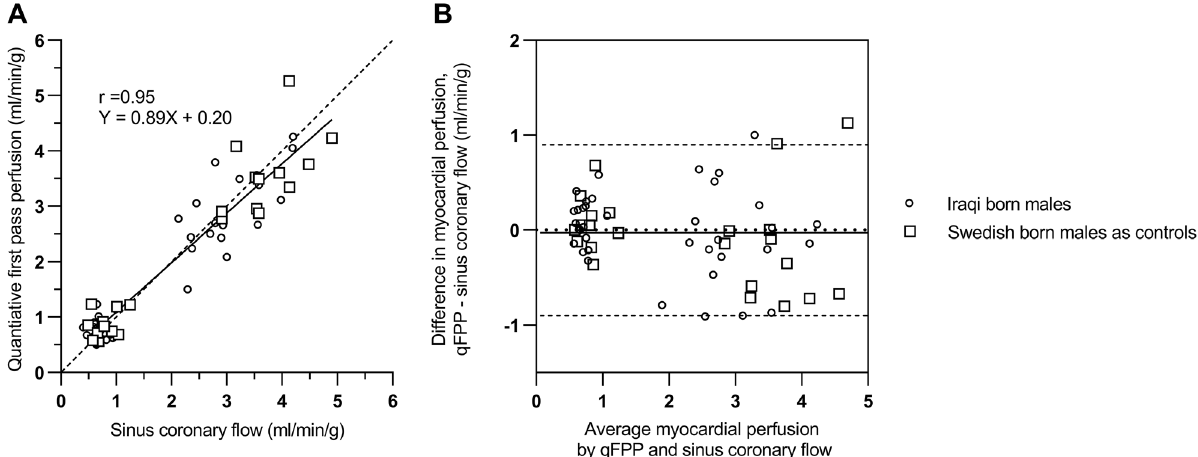
Figure 5. The relationship between global quantitative first pass perfusion (qFPP) and coronary sinus flow at rest and stress in Iraqi males (open circles) and Swedish born males as controls (open squares). ( A ) Global qFPP plotted against coronary sinus flow with the dashed lined representing the line of identity and solid line representing linear regression (r = 0.95, y = 0.89x + 0.20). ( B ) Agreement between qFPP and sinus coronary flow, bias 0.02 ± 0.5 ml/min/g. Dashed lines represent ± 2SD and solid line represent